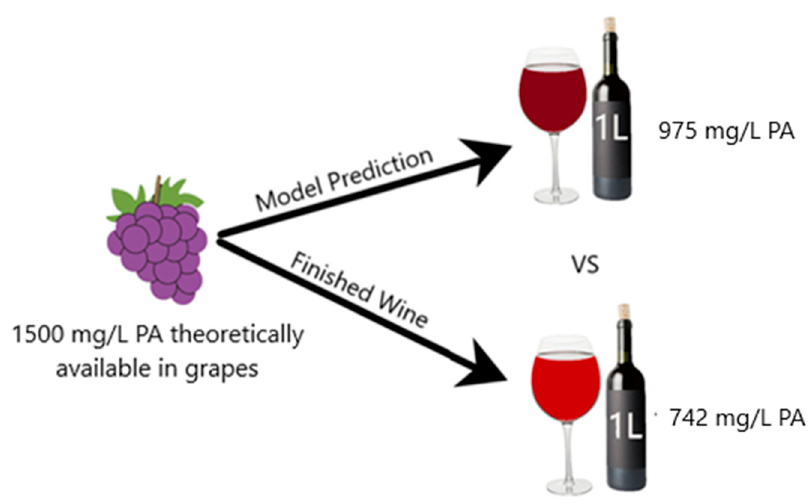
Figure 5. Theoretical representation of model prediction versus winemaking outcome disregarding impact from maceration.